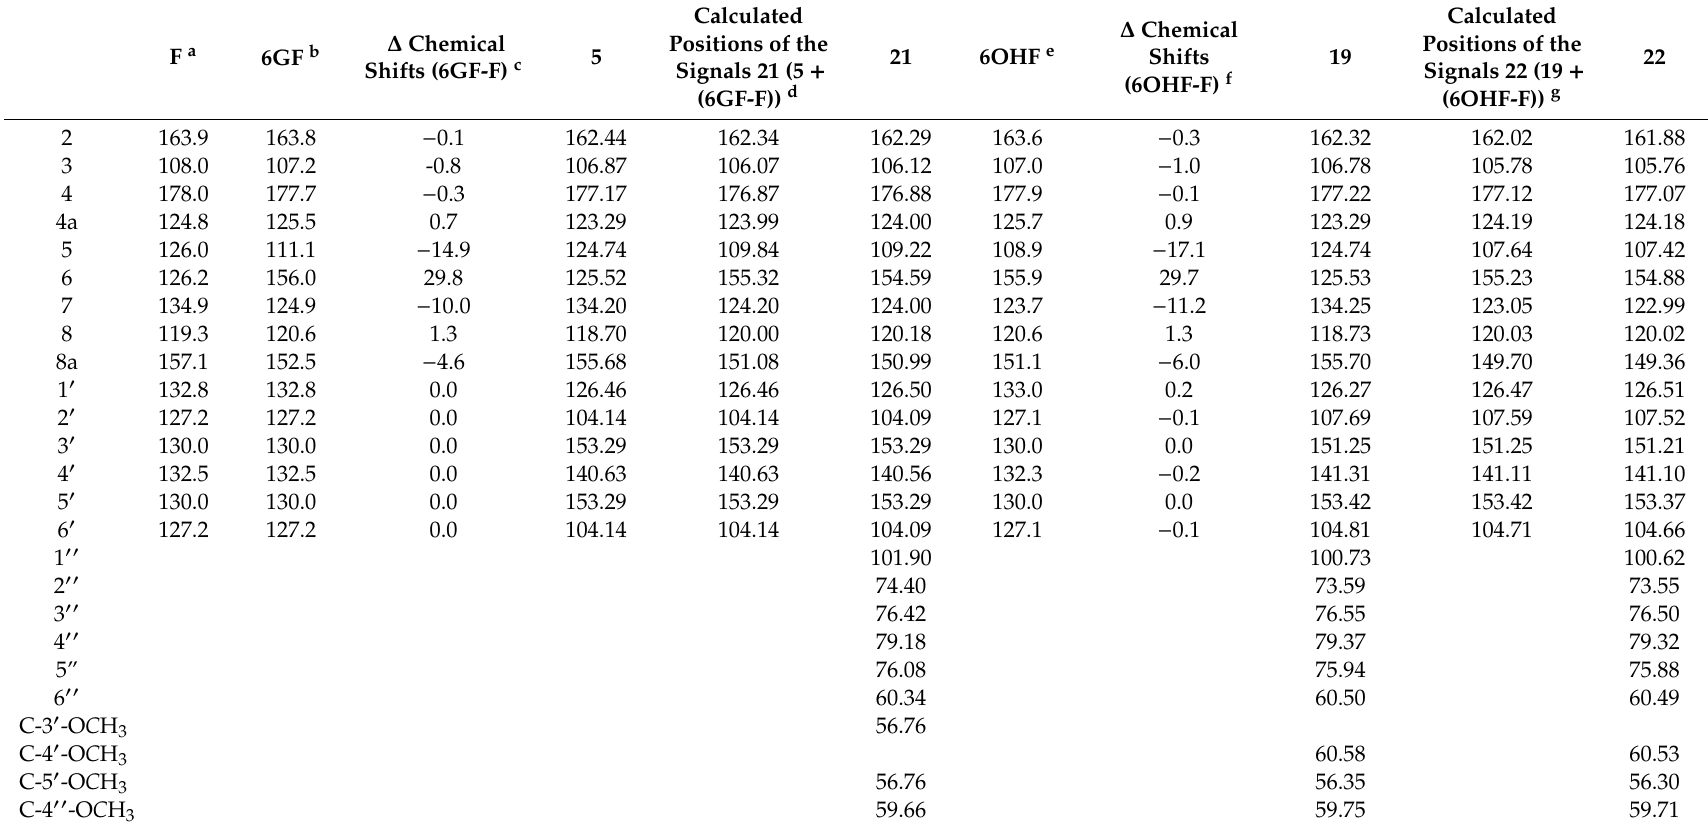
Table 7. Calculated and measured positions of signals visible in the 13 C NMR